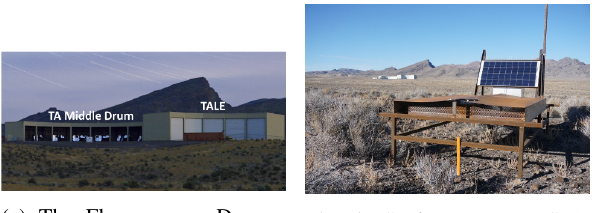
Figure 3: (a) : The Middle Drum station for TA experi- ment is on the left, and the TALE-FD station on the right. (b) : The scintillator under the brown iron observes the charged particles.